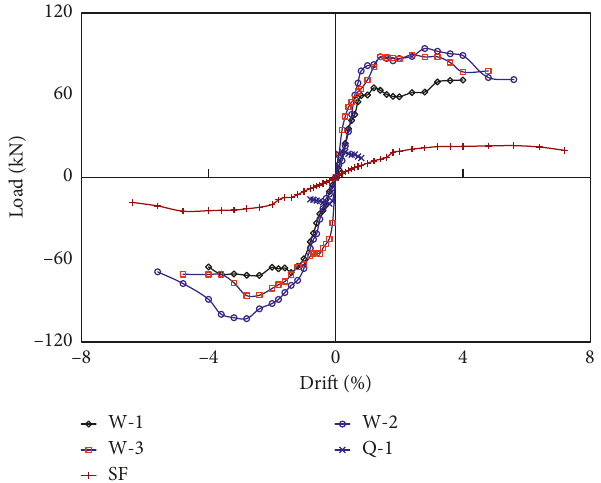
Figure 10: Skeleton curves.